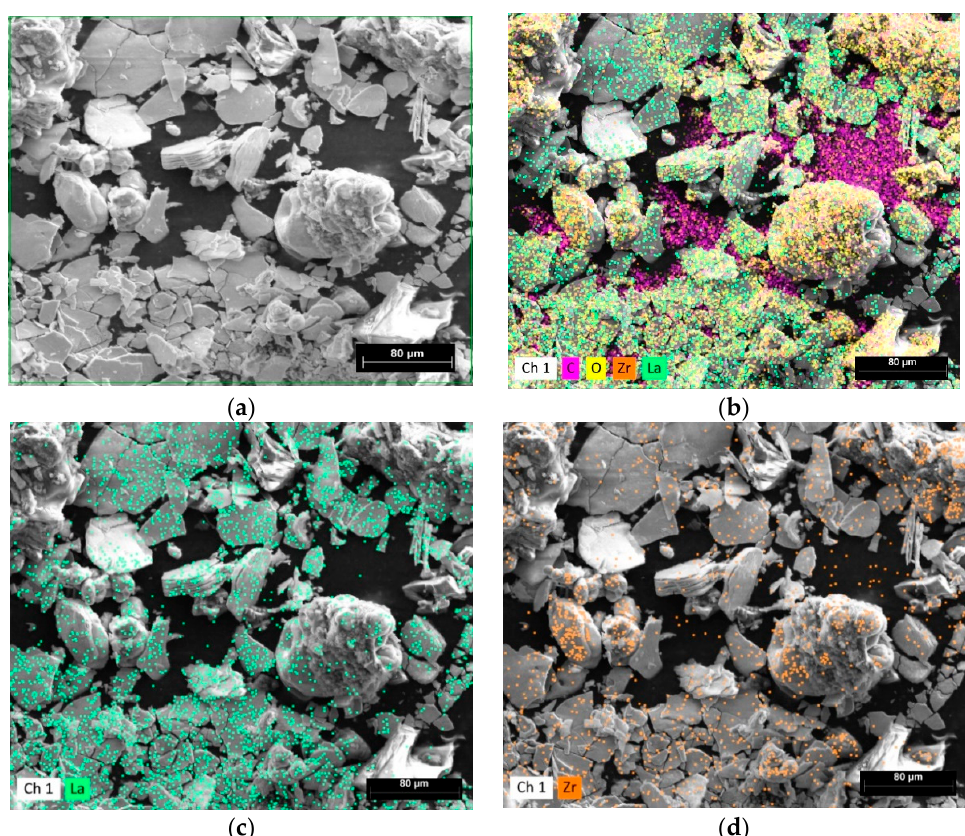
Figure 3. SEM images of the synthesized LLZO powder at different magnifications. The scale bar is ( a , b ) 20 μ m, and ( c , d ) 5 μ m long. ( a , b ) 20 µ m, and ( c , d ) 5 µ m long. Table 1. Elemental EDS analysis of Li 7 La 3 Zr 2 O 12 powder. Element Mass, wt.% Lanthanum 53.19 Table 1. Elemental EDS analysis of Li 7 La 3 Zr 2 O 12 powder. Oxygen 22.59 Element Mass, wt.%